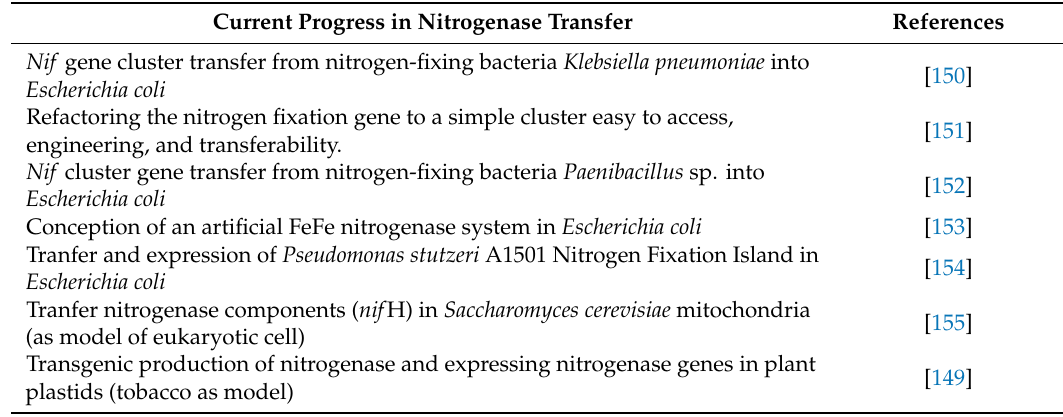
Table 3. Summary of some successful steps achieved in nitrogen transfer from legumes to non-legumes. Current Progress in Nitrogenase